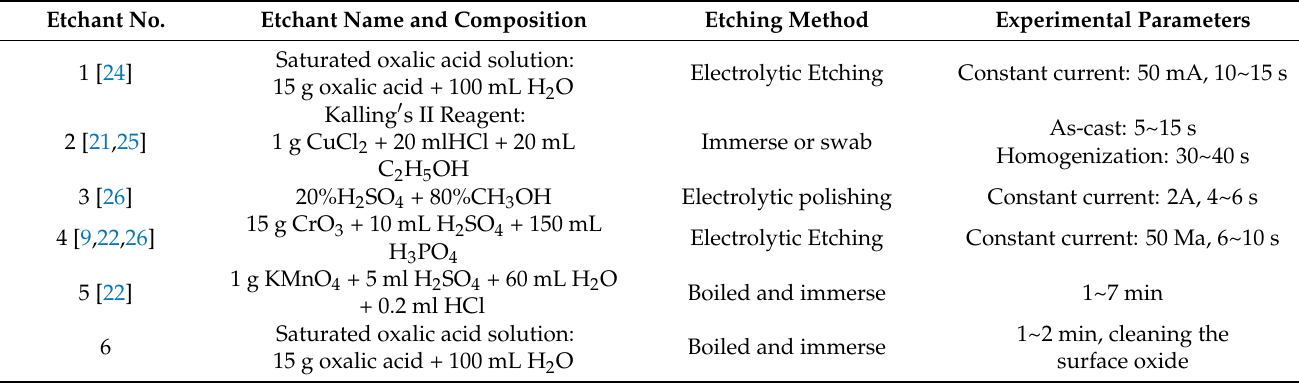
Table 2. Types and etching methods of etchants for superalloy